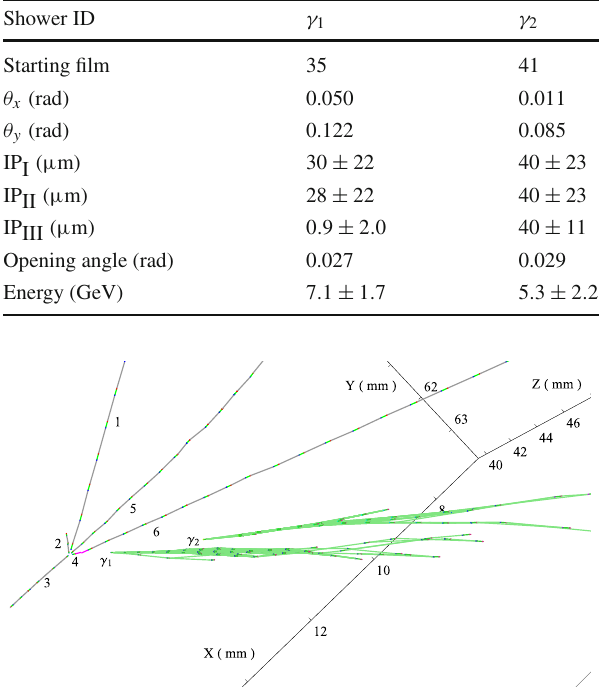
Fig. 6 Reconstruction of the electromagnetic showers associated to the event